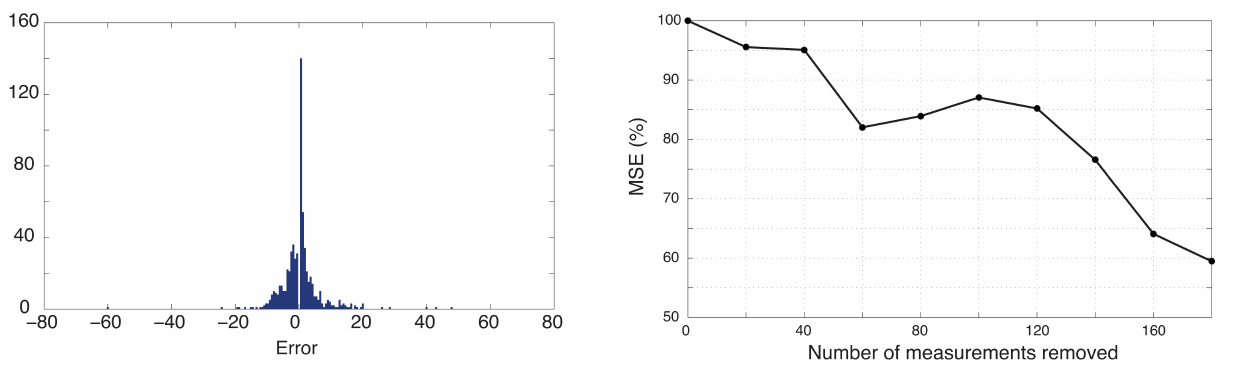
Figure 2. MSE of reconstruction obtained using Eq. (2). The strongest outlier measurements (the ones associated with the largest errors) have been removed manually. Notice that the MSE decreases as more outliers are